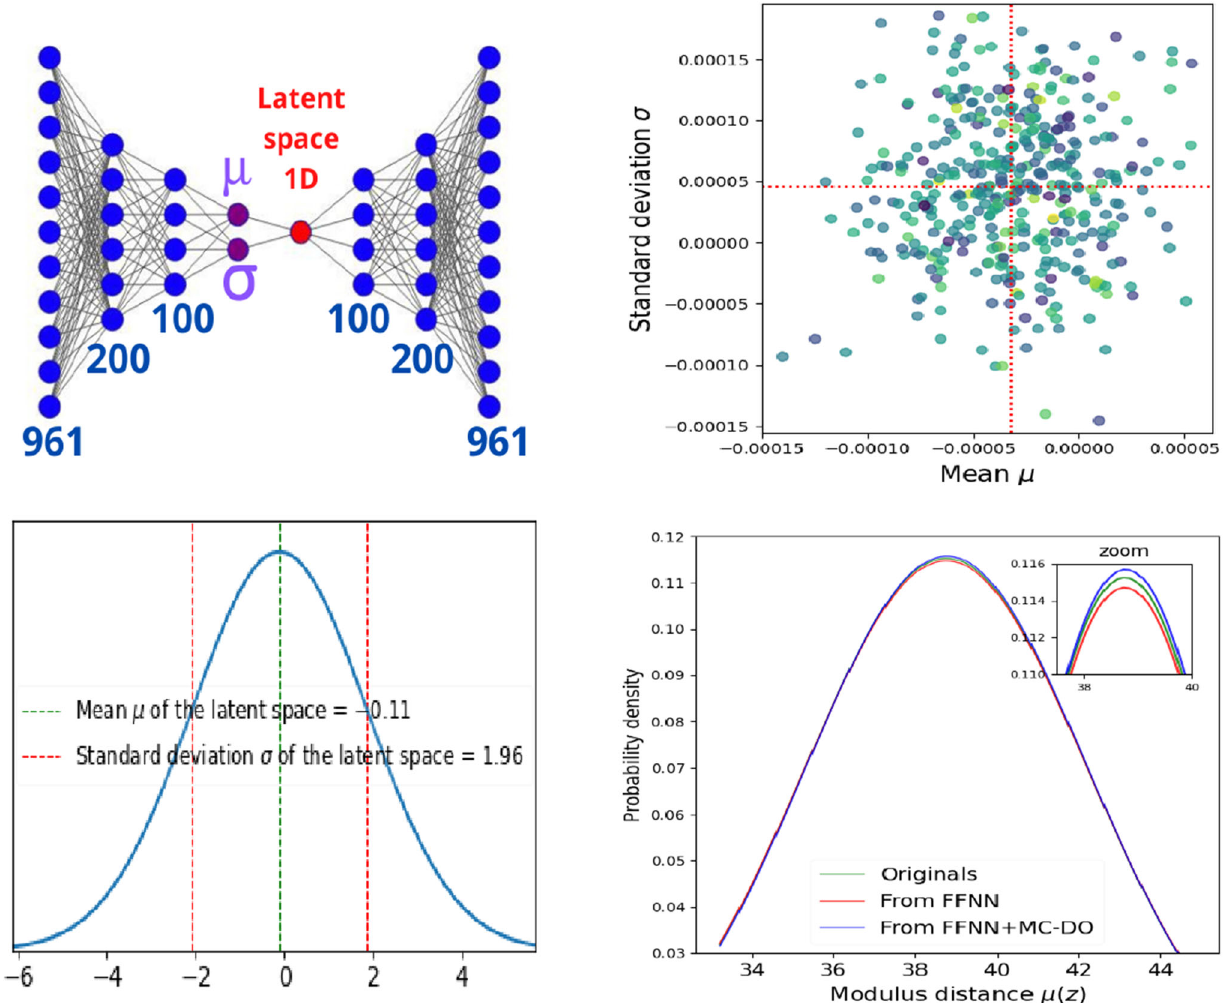
Fig. 8 VAE results. Top left: VAE architecture. Top right: Samples of the mean and variance layers. Lower left: Sampled distribution of the latent space. Lower right: Comparison between the distributions for the